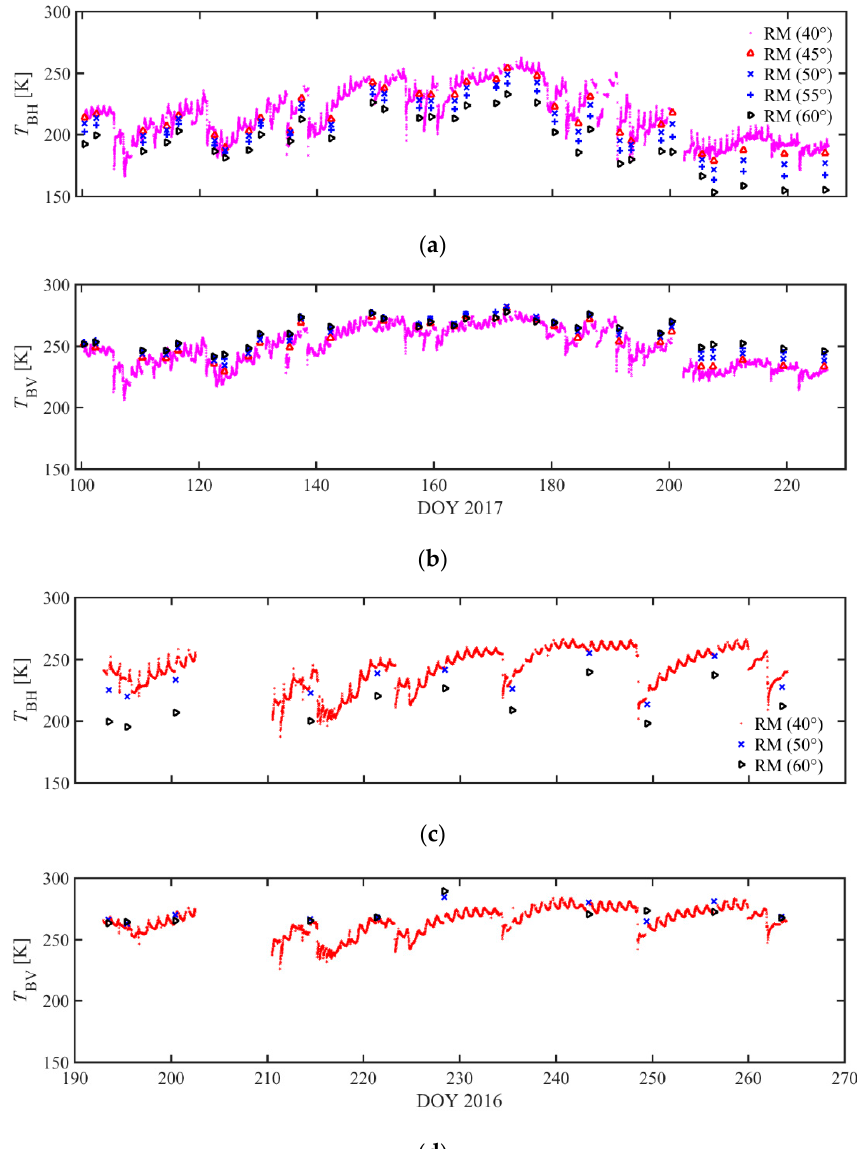
Figure 6. Brightness temperature ( T B ) measured for of the non-gridded plot covered by wheat vegetation at different incidence angles from 40° to 60° measured in 5° increments for H polarization ( a ) and V polarization ( b ). T B measurements for the non-gridded plot covered by mustard vegetation considering also incidence angles from 40° to 60°, but with 10° increments for H polarization ( c ) and V polarization ( d ).